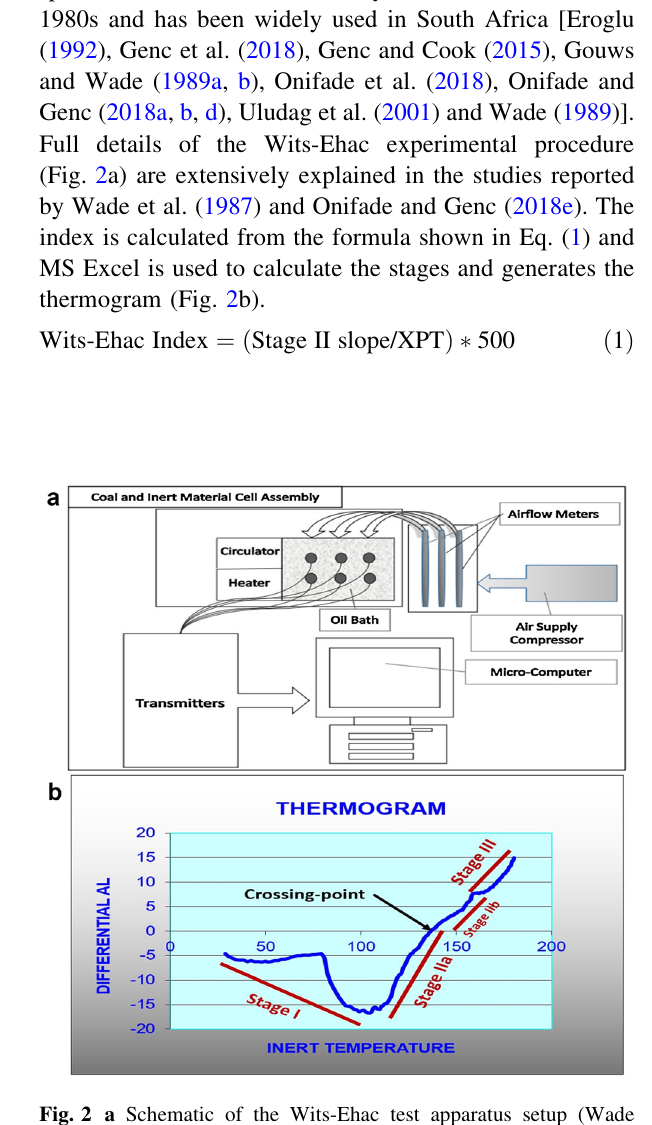
Fig. 2 a Schematic of the Wits-Ehac test apparatus setup (Wade et al. 1987). b Typical differential thermogram of a coal